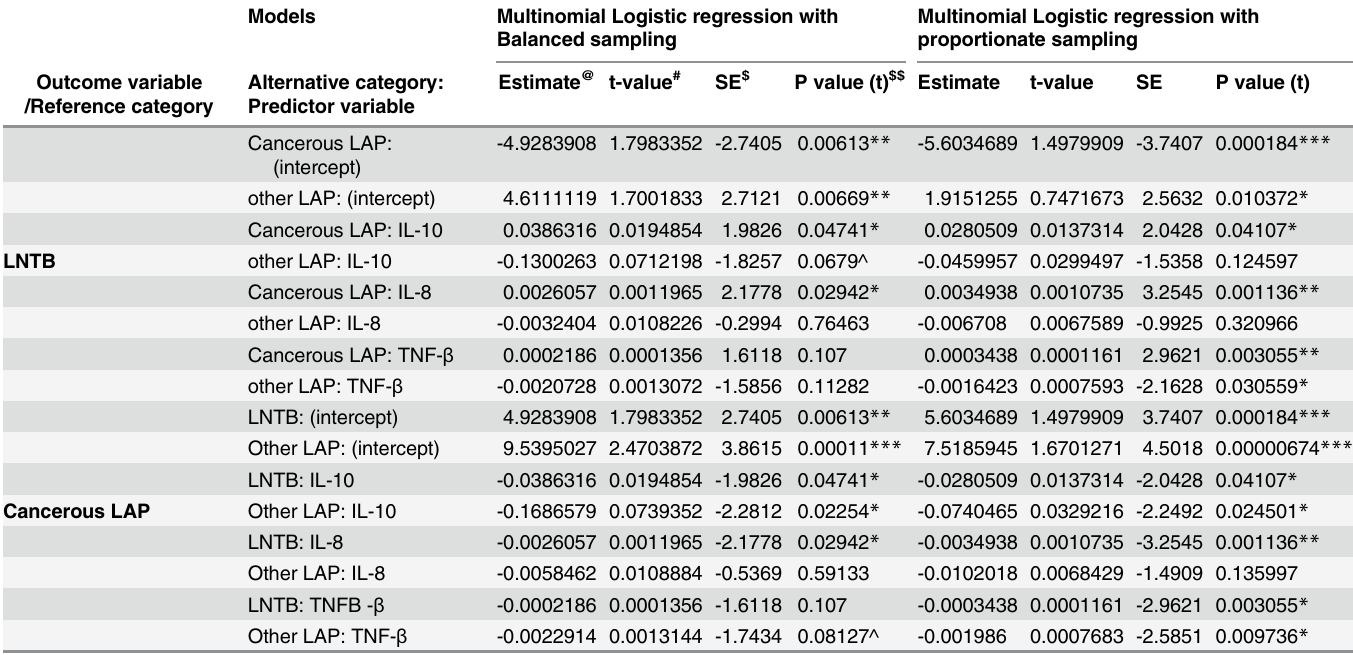
Table 3. Summary of model characteristics for classifying LNTB from Cancerous LAP and Other